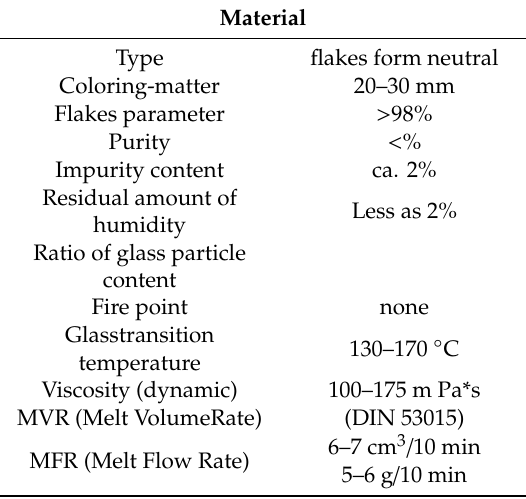
Table 1. Characterization of selected polyvinyl butyral.